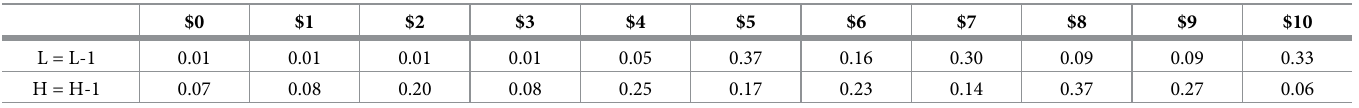
Table 7. One-sided Fisher p -values comparing total acceptances per treatment.